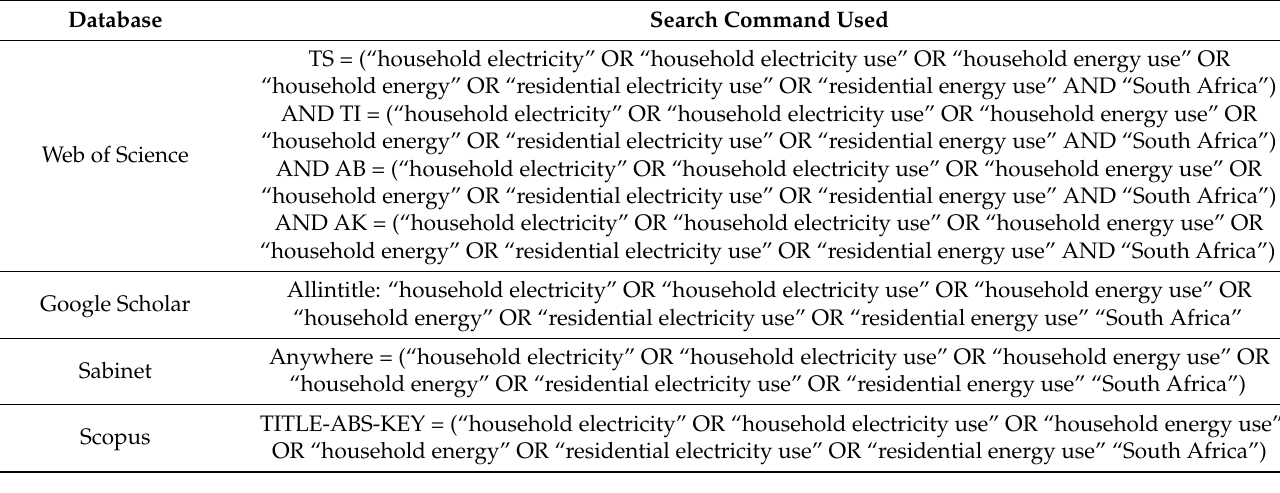
Table 1. Databases and search commands